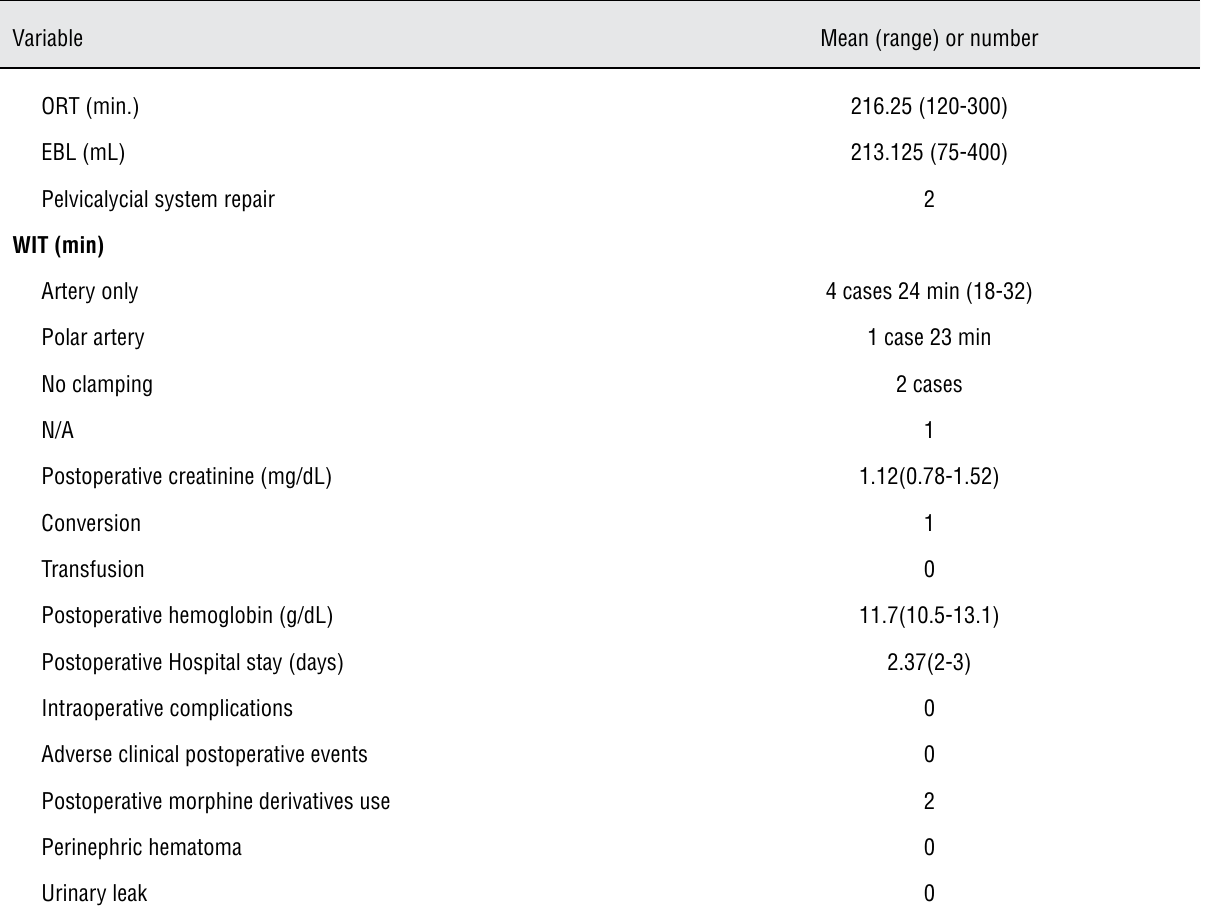
Table 2 - Perioperative variables.